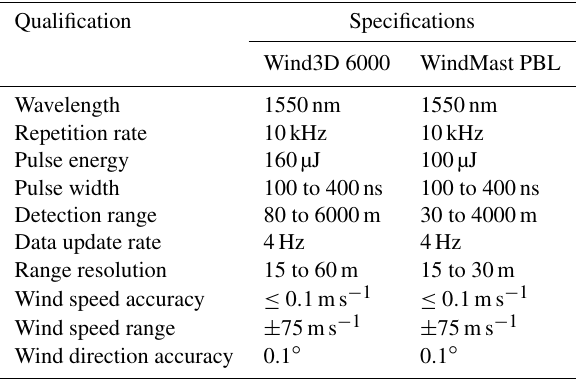
Table 2. Overview of CDL specifications used for Aeolus valida-